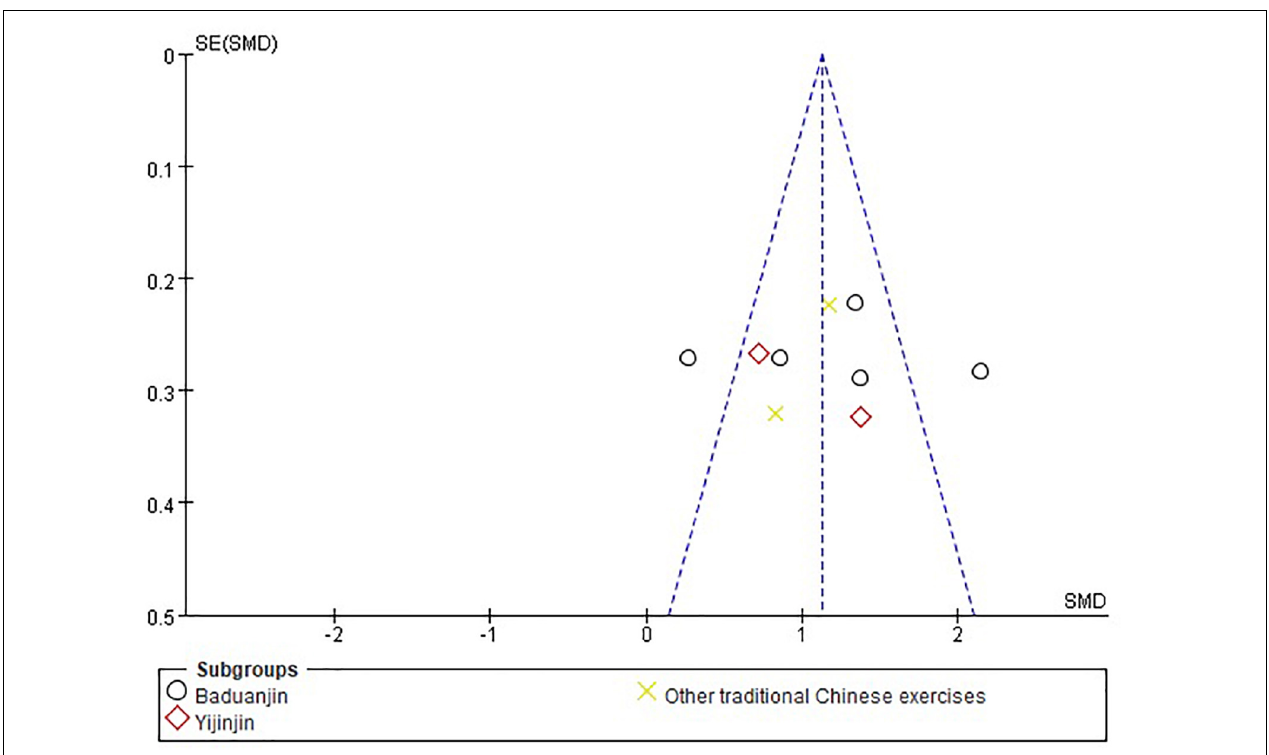
FIGURE 4 | The funnel plots of the complementary effects of TCEs for neck pain in relieving